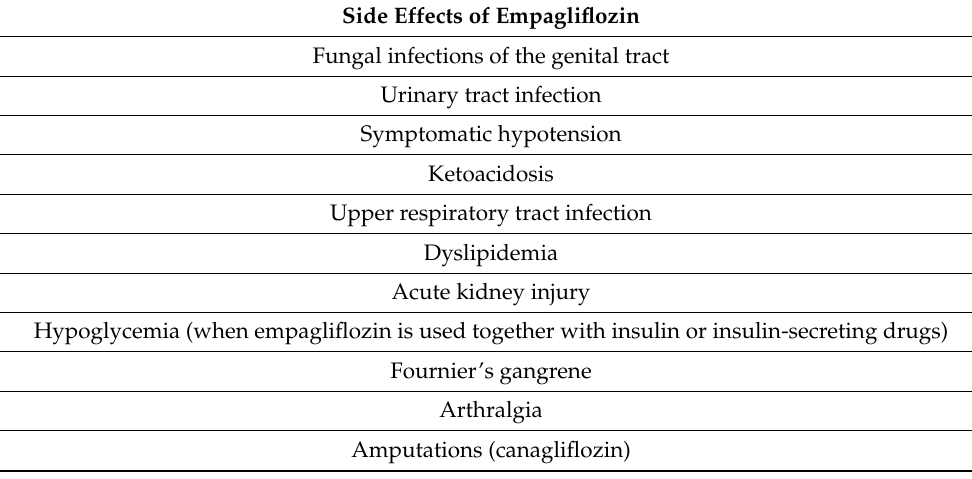
Table 1. Examples of empagliflozin side effects